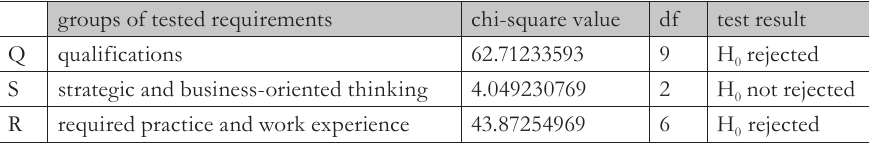
Tab. 2 – Overview of results of individual requirement group testing. Source: Author´s inde- pendent